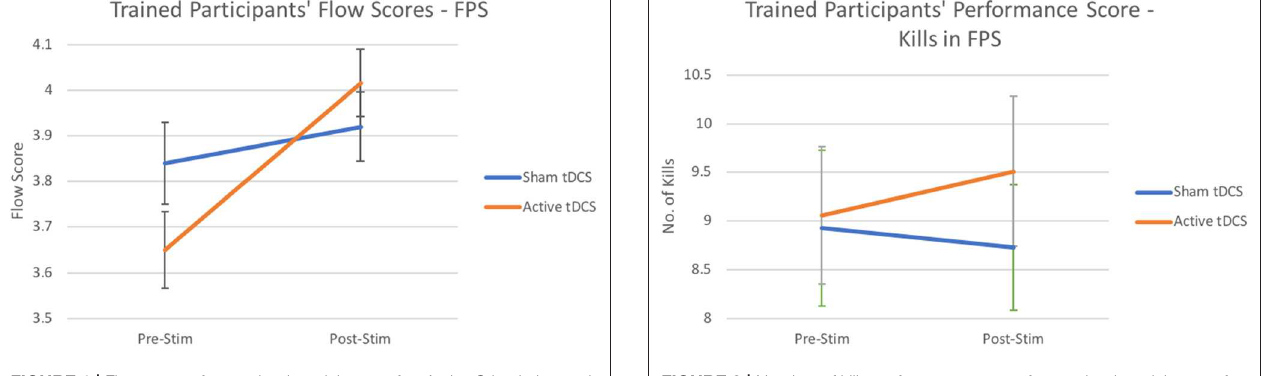
FIGURE 1 | Flow scores from trained participants after Active Stimulation and Sham Stimulation. Bars—Standard Error.